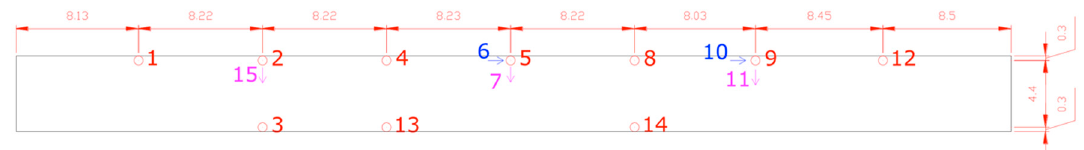
Figure 5. The pedestrian bridge in the “Ospedale del Mare” hospital complex in Naples, Italy. Figure 6. “Ospedale del Mare” footbridge: sketch of the plan view and sensor layout (length in m).